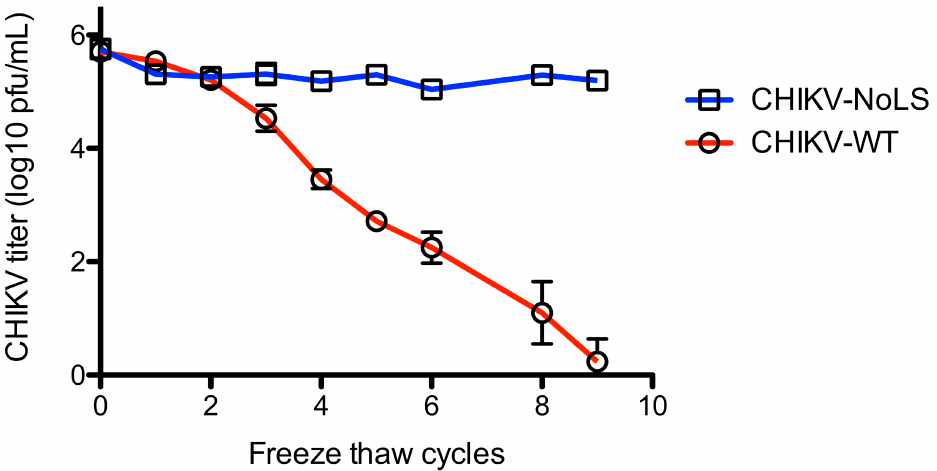
Figure 6. Stability of CHIKV-NoLS infectivity following repeated freeze thaw cycles. CHIKV-NoLS and CHIKV-WT were diluted to 5 × 10 5 PFU/mL and vials stored at –80 °C. Vials were thawed on ice and infectious CHIKV-NoLS and CHIKV-WT quantified by plaque assay. Vials were returned to –80 °C and the process repeated. Each symbol represents the mean ± standard error.